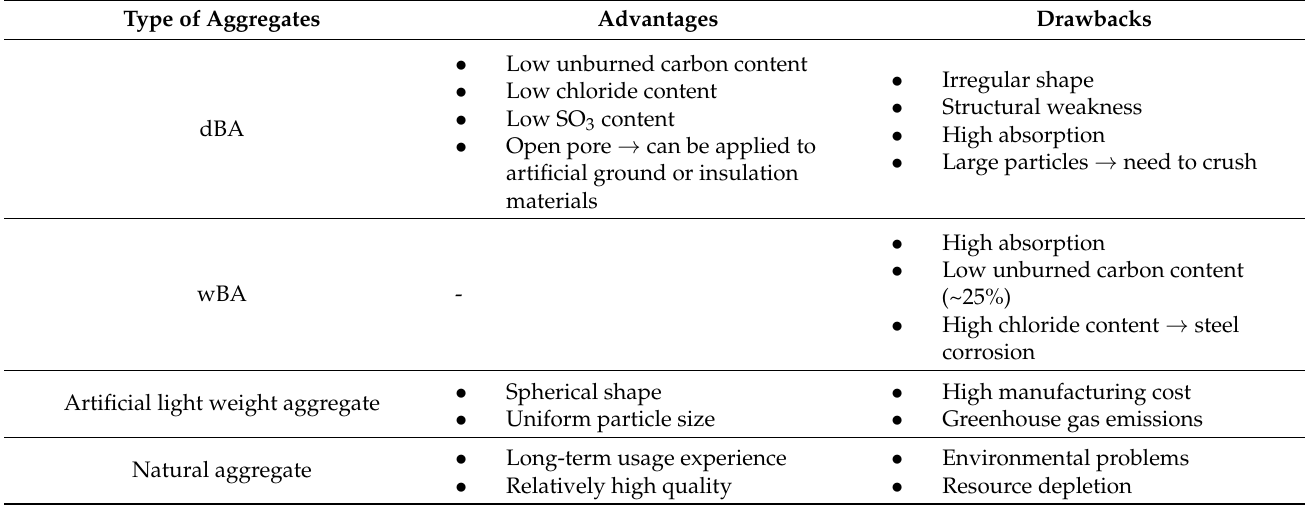
Table 2. Comparison of various aggregates.